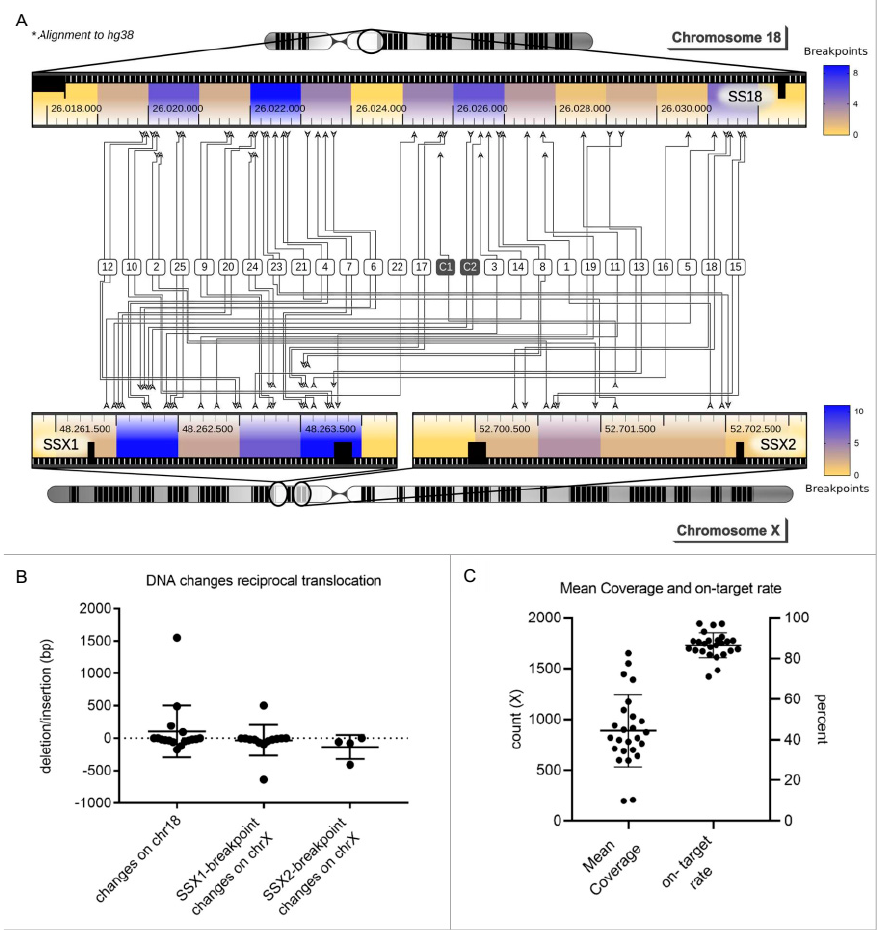
Figure 1. Mutational profiling of synovial sarcomas. ( A ). Heat map: 25 SS tumors and 2 cell lines (Fuji and HS-SY-II ) were sequenced with the subtype-specific panel for SS. Chromosomal translocations could be detected in all 25 tumors (1–25) and both cell lines (C1, C2). Both breakpoints were found in 17/25 tumors (68%). Fusion occurred between SS18 ( SYT ) in chromosome 18 and SSX1 or SSX2 in chromosome X. In total, 76% of the tumors had an SSX1 breakpoint and the remaining 24% had a breakpoint in SSX2 . Areas with an increased likelihood of chromosomal breaks are colored in blue. ( B ). For the 17 tumors where both breakpoints were identified, loss or gain of DNA during the translocation event could be determined. A mean change of 104 bp, standard deviation (SD) of 400 bp, occurred on chromosome 18. On chromosome X at SSX1 and SSX2 , a mean change of − 32 bp (SD 235 bp) and − 135 bp (SD 185 bp) occurred, respectively. Bars depict the mean and SD for 17 tumors. ( C ). Mean coverage of all tumors was 889 x (SD 357 x), and the mean on-target rate was 86.5% (SD 6.2%). Bars depict the mean and SD for 17 tumors.